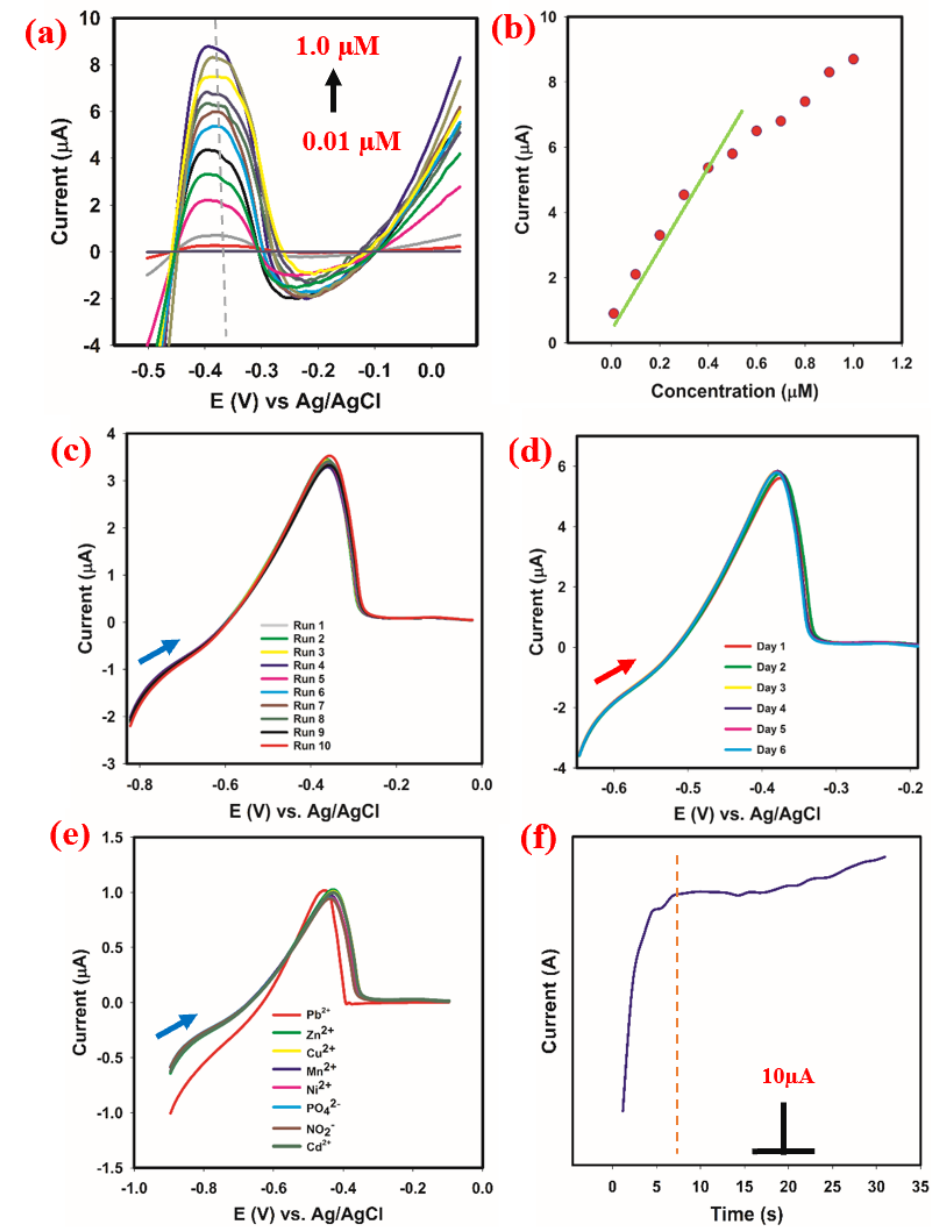
Figure 5. ( a ). Calibration plot using linear sweep voltammetry with PANI-GO-APTES-modified GCE as working electrode. ( b ) Plot of peak current versus concentration of Pb 2+ . ( c ) The recorded linear sweep voltammogram in 10 successive runs in 0.2 µM. ( d ). The recorded linear sweep voltammogram using different GCEs modified with PANI-GO-APTES in 0.2 µM. ( e ) The obtained linear sweep voltammogram for Pb 2+ in the presence of added metals (interferents) in 0.01 µM. ( f ). Response time for PANI-GO-APTES in 100 nM Pb 2+ in 0.2 µM.